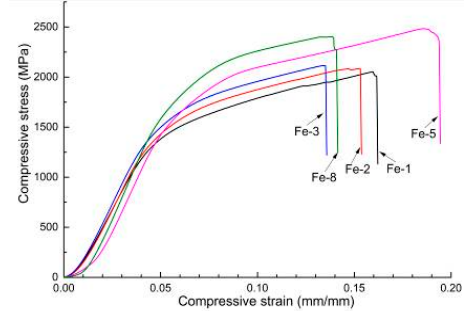
Figure 7. Stress–strain curves of alloys doped with Fe.